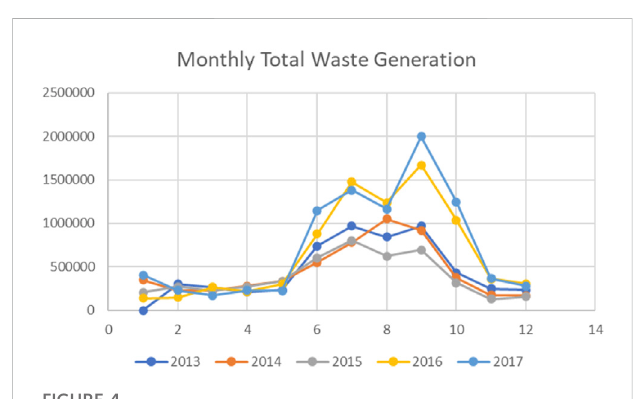
FIGURE 4 Monthly total waste generation from 2013 to 2017.